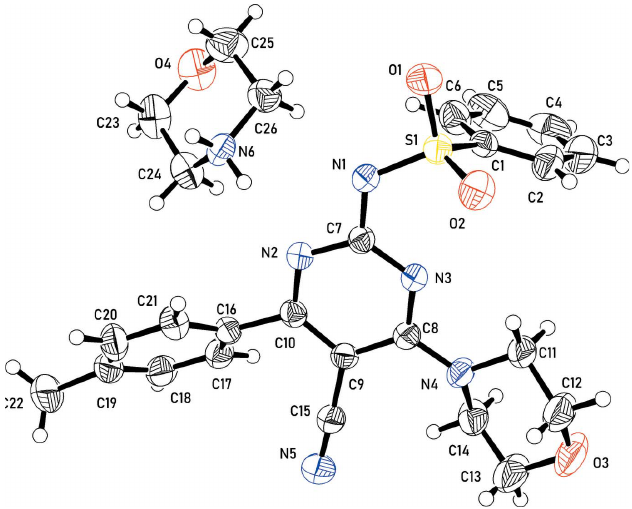
Figure 1 The asymmetric unit of 5 showing 50% probability displacement ellipsoids.